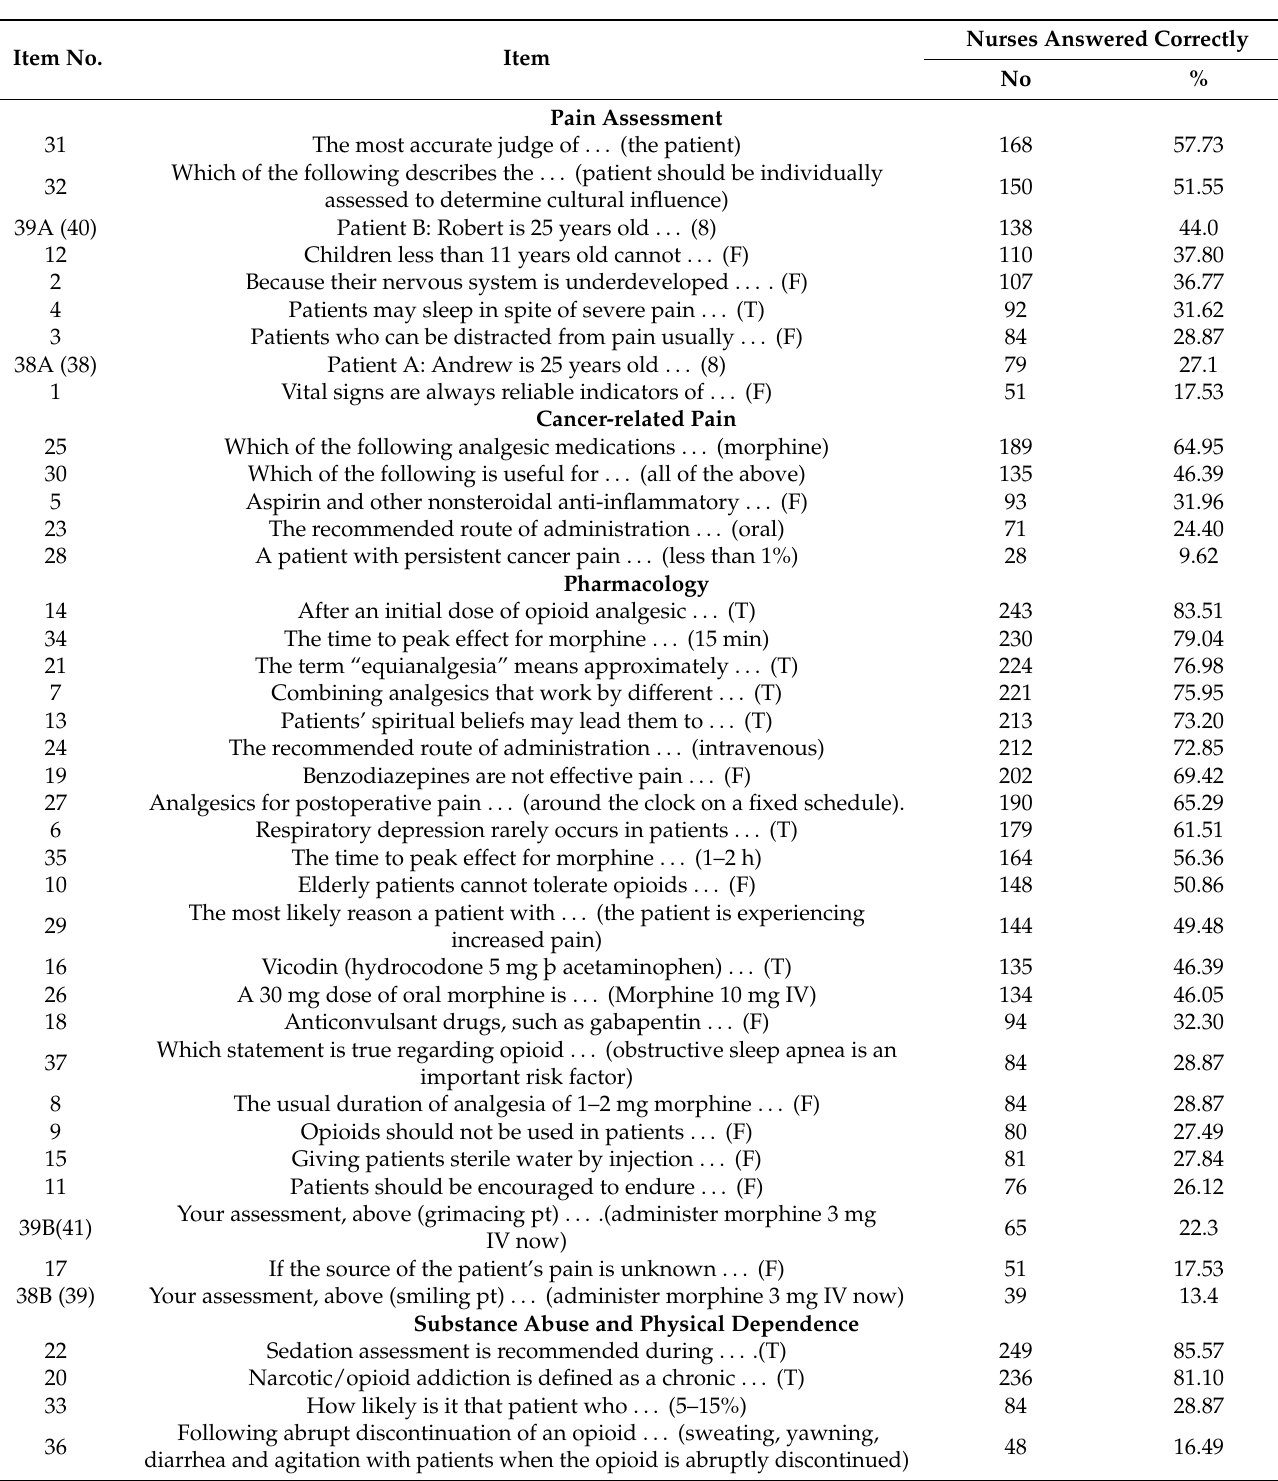
Table 2. Correct responses for each item of the KASRP ( n =